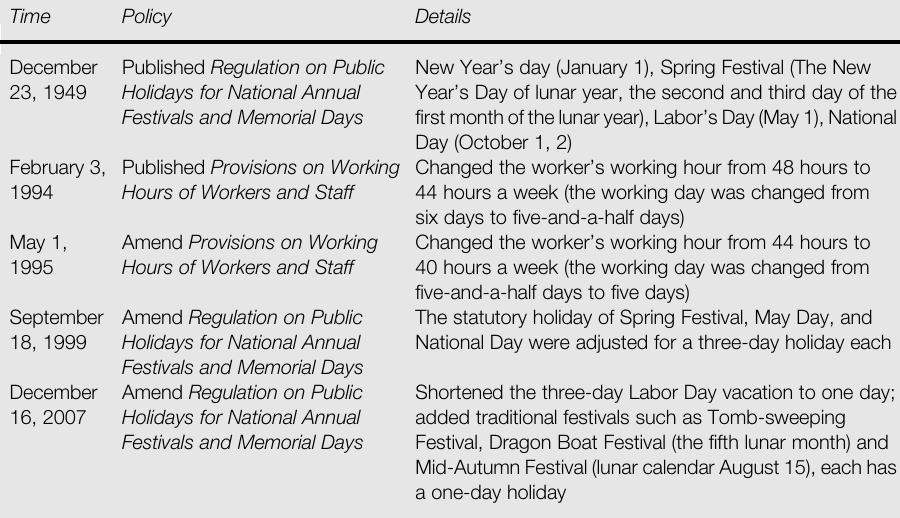
Table I The reform of Chinese residents ’ vacation